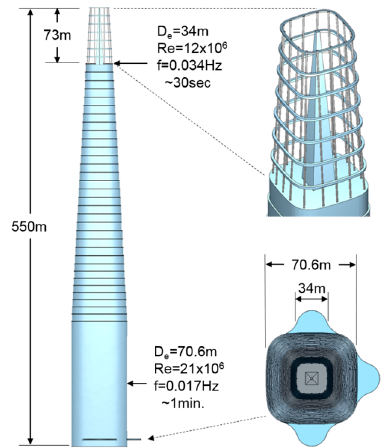
Figure 7. Dimensions of the Lotte World Tower design and rooftop structure: ( left ) side view; ( right-top ) perspective view of rooftop structure; and ( right-bottom ) top view.